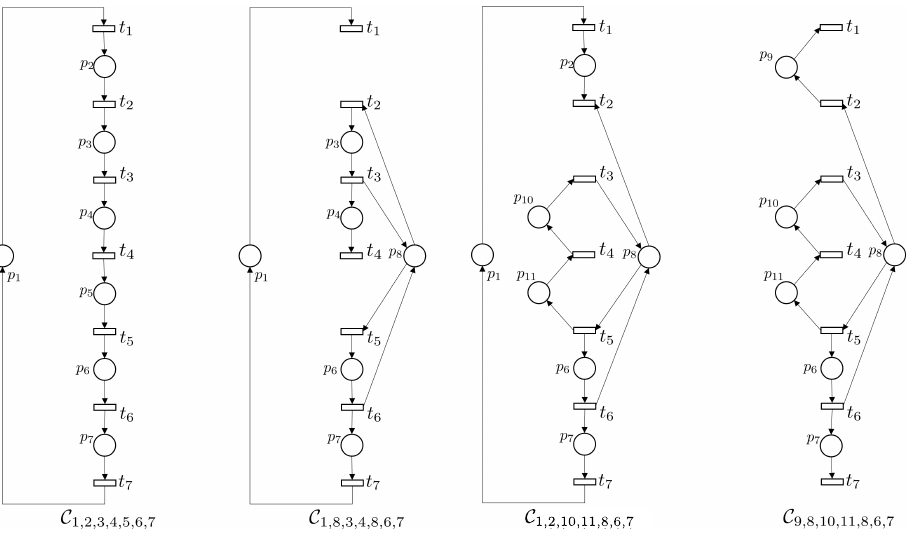
Figure 4. Induced nets associated with 4 of the 64 configurations of the net depicted in Figure